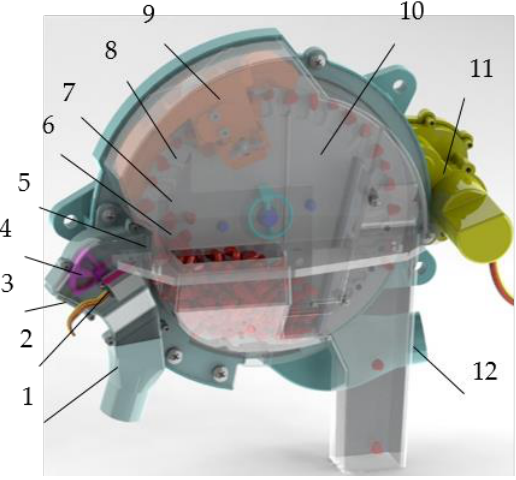
Figure 4. Structural figure of the pneumatic maize seed meter. Note: 1, air duct in positive pressure type; 2, steering engine; 3, exhaust port; 4, flow-divider valve; 5, air nozzle; 6, maize; 7, the upper cover of seed meter; 8, seed guided groove of seed disc; 9, seed cleaning device; 10, seed disc; 11, drive motor; 12, air duct in negative pressure type.